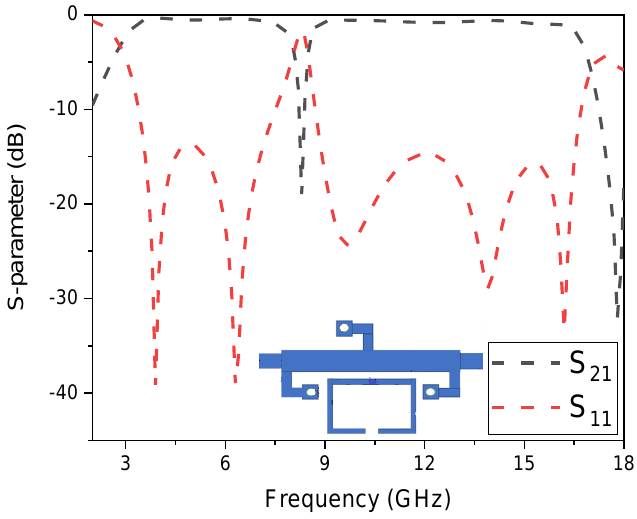
Figure 7. Response of the proposed C-shaped resonator at 8.3 GHz.